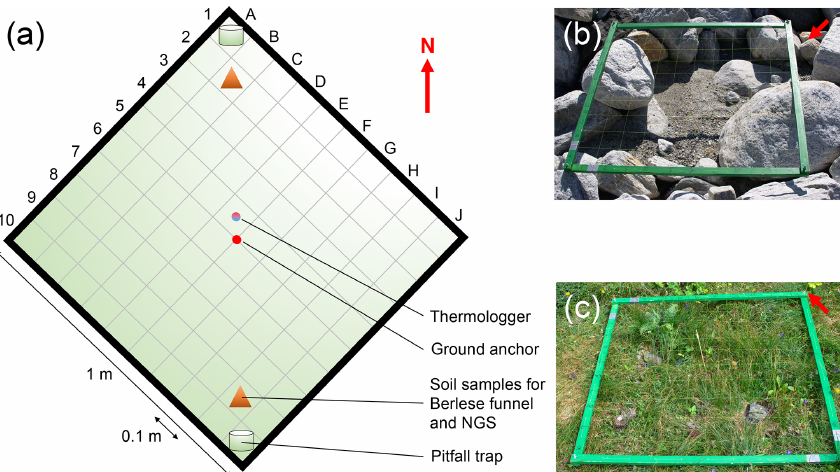
Figure 2. Plot design. In summer 2019 we established n = 140 plots along the successional gradient of the Ödenwinkelkees glacier in Land Salzburg, Austria. The majority of the plots ( n = 135) were established within the glacier forefield, i.e., the area that was covered by ice at the latest glacial maximum. Another n = 5 plots were established outside the glacier forefield in areas unaffected by geomorphological influences (i.e., age (cid:29) 170 years). Location of plots can be found in Fig. 1 and Supplement 1a. Each plot is defined by a square with 1m side length and a ground anchor as the center of the plot, resulting in an area of 1m 2 . One tip of the square is pointing towards north (red arrow). Each plot is divided into 100 grid cells (A1–J10). These grid cells allow the rediscovery of the position of samples taken within the plot. Note that the locations of the measurements (thermologger, soil samples, and pitfall traps) are located at different positions and grid cells in each plot (see Supplement 1), accounting for the heterogenous distributions of rocks and soil in each of the plots. An early-succession ( b , plot_002) and an old-succession plot ( c , plot_123) are